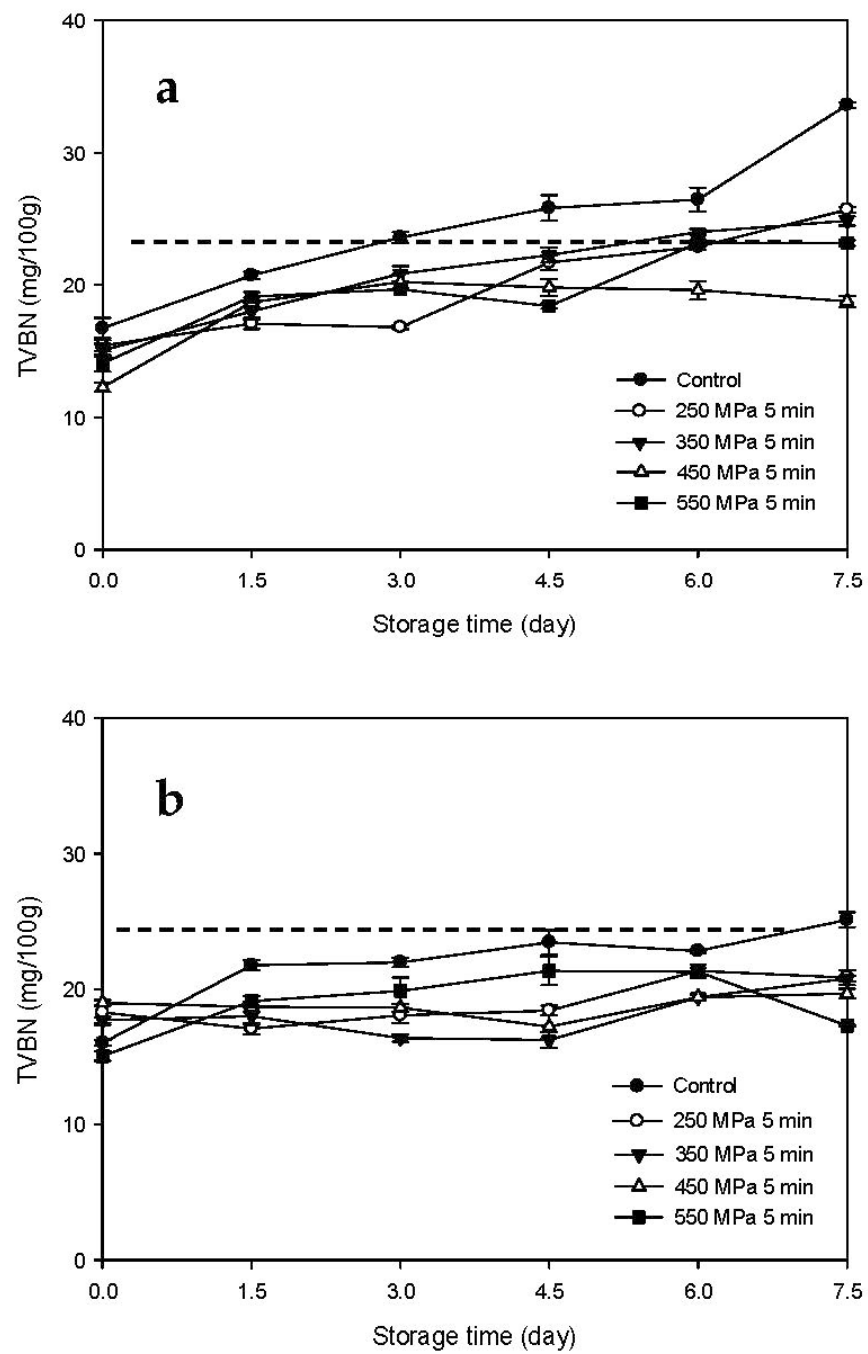
Figure 5. Changes in total volatile basic nitrogen (TVBN) contents of tuna meat samples inoculated with ( a ) Morganella morganii and ( b ) Photobacterium phosphoreum after high-pressure processing treatment at 250, 350, 450, and 550 MPa for 5 min during storage at 15 °C; dash line indicates the sanitation standard for fish products as 25 mg/100 g of TVBN.